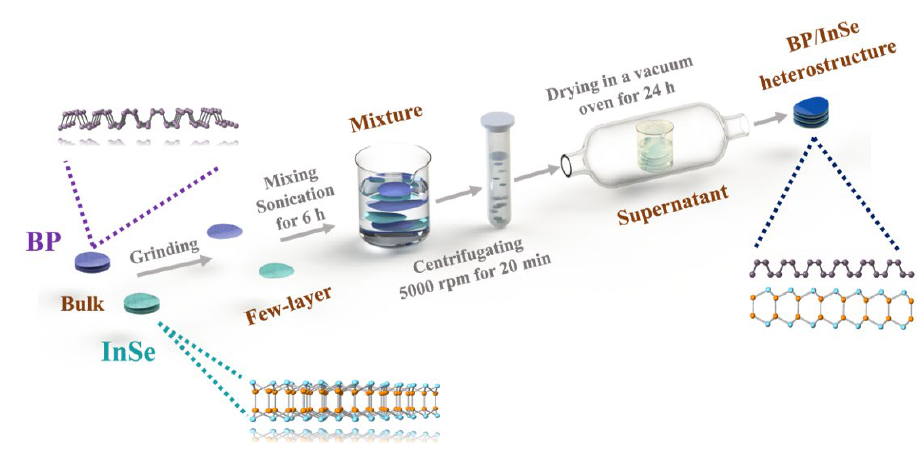
Figure 1. Schematic process for preparing 2D BP/InSe heterostructure by the LPE method.